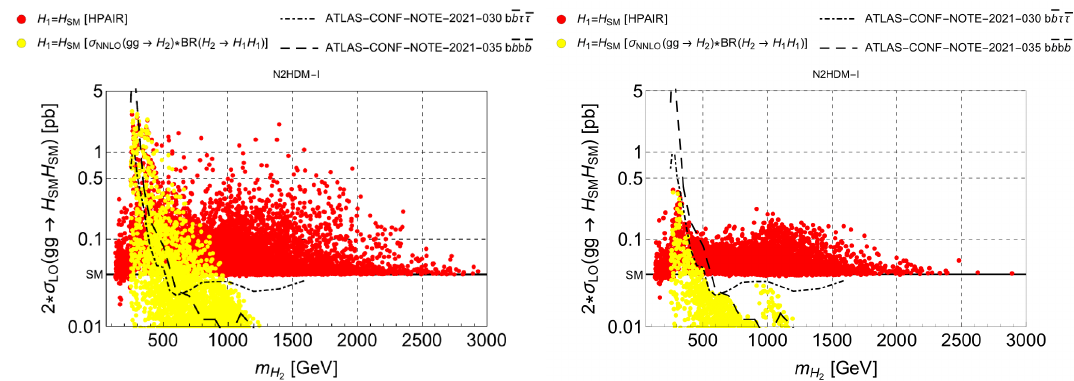
Figure 3 . N2HDM-I: yellow points: σ ( pp → H 2 ) SusHi × BR ( H 2 → H 1 H 1 ) . Red points: 2 × NNLO ( gg → H ) , with H , as function of m . Left (right) panel without (with) σ HPAIR SM H SM SM ≡ H 1 H 2 LO the constraints from experimental resonant di-Higgs searches, cf. text for details. The dashed (dot- dashed) line denotes the ATLAS limit from the ( b ¯ b )( b ¯ b ) ( ( b ¯ b )( ττ ) ) final state. Horizontal line: